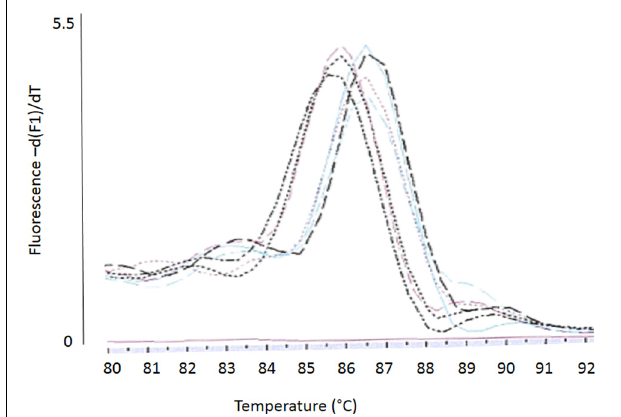
FIGURE 4 | Conventional melting curve analysis (Lightcycler I.I, SYBR-Green) of eme A-amplicons resulting in two different eme A types: type 1 (higher Tm) and type 2 (lower Tm).